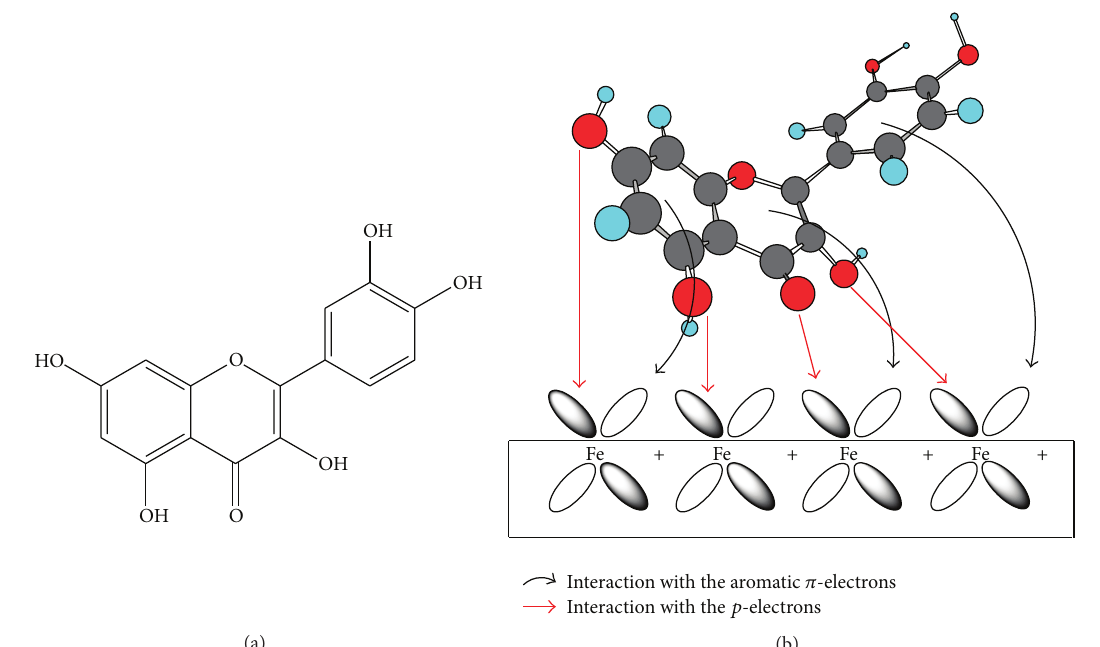
Figure 7: (a) Chemical structure of quercetin and (b) interaction of quercetin active sites with the 304SS surface [30].